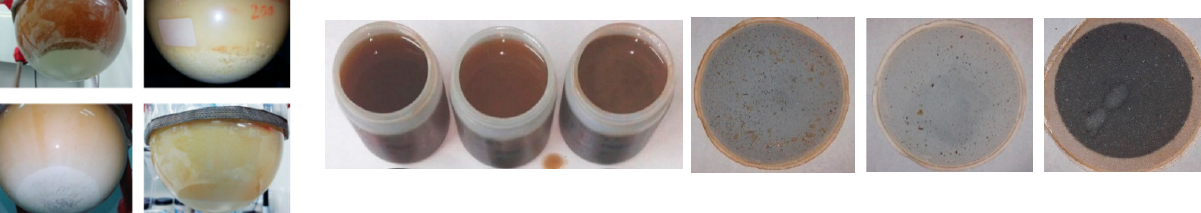
Figure 4. Example of glycolyzed products at 2 h of PU reaction: RPUF ‐ B ( left ); RPUF ‐ C ( right ). Liq ‐ uid phase R5, R6, R7. Solid phase non ‐ reacted material after filtration R5, R6,